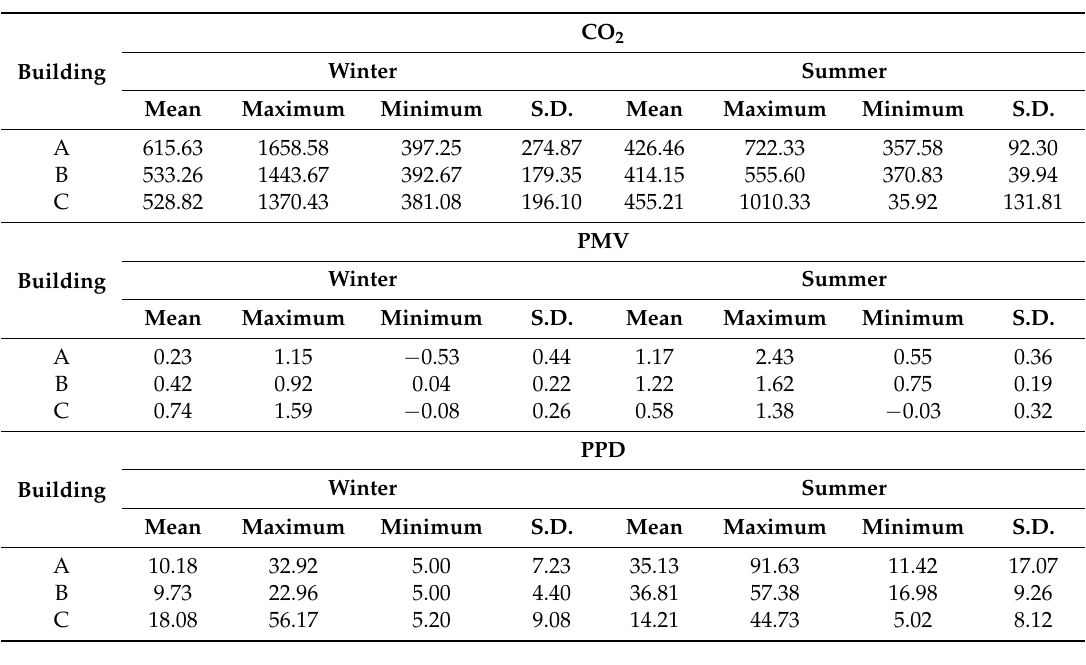
Table 4. Results of the in situ measurements regarding CO 2 , predicted mean vote (PMV) and predicted percentage of dissatisfied (PPD) index during winter and summer period, per